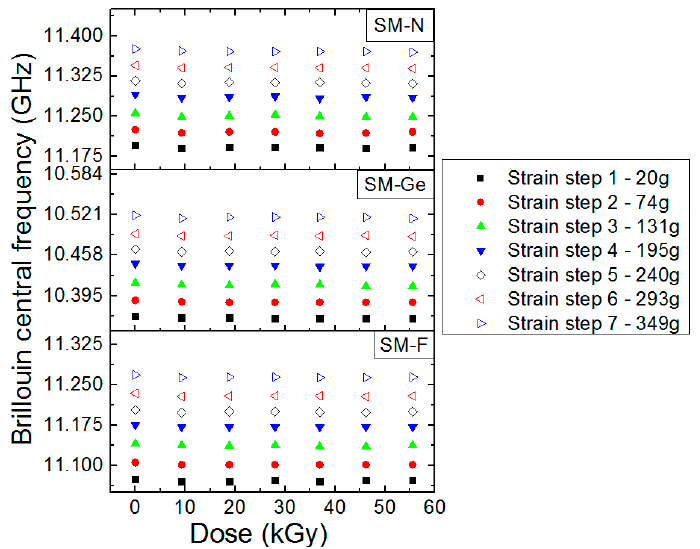
Figure 7. Evolution of the Brillouin central frequency as a function of the dose for SM-F, SM-Ge and SM-N fibers during the irradiation run at the dose rate of 370 Gy/h and different stain conditions in the various parts of the differently strained FUT.